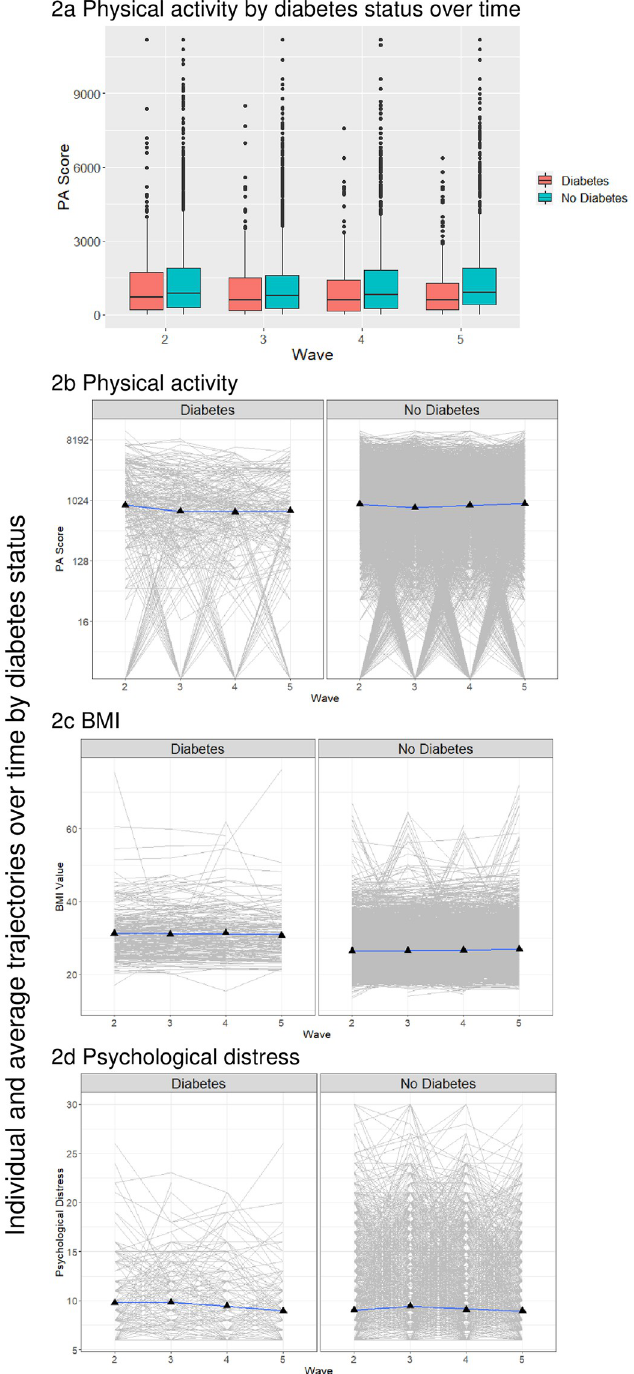
Fig 2. Changes over time by diabetes status. Notes: For parts b to d, the black triangles represent the average (mean) value at each wave, the colored line represents the mean trajectory, the grey lines show individual trajectories. Part b has the y-axis shown on a log base 2